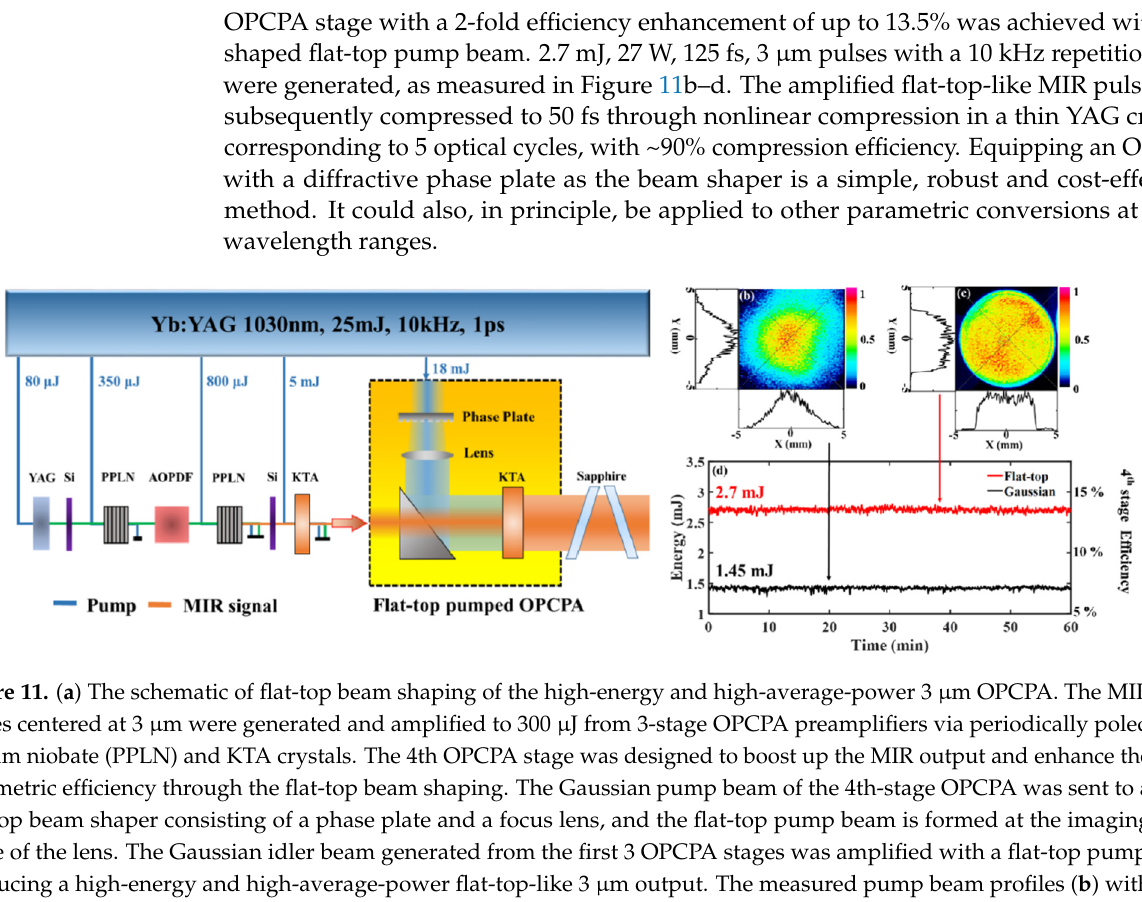
Table 4. Parameters of the long-wavelength MIR OPCPA systems.